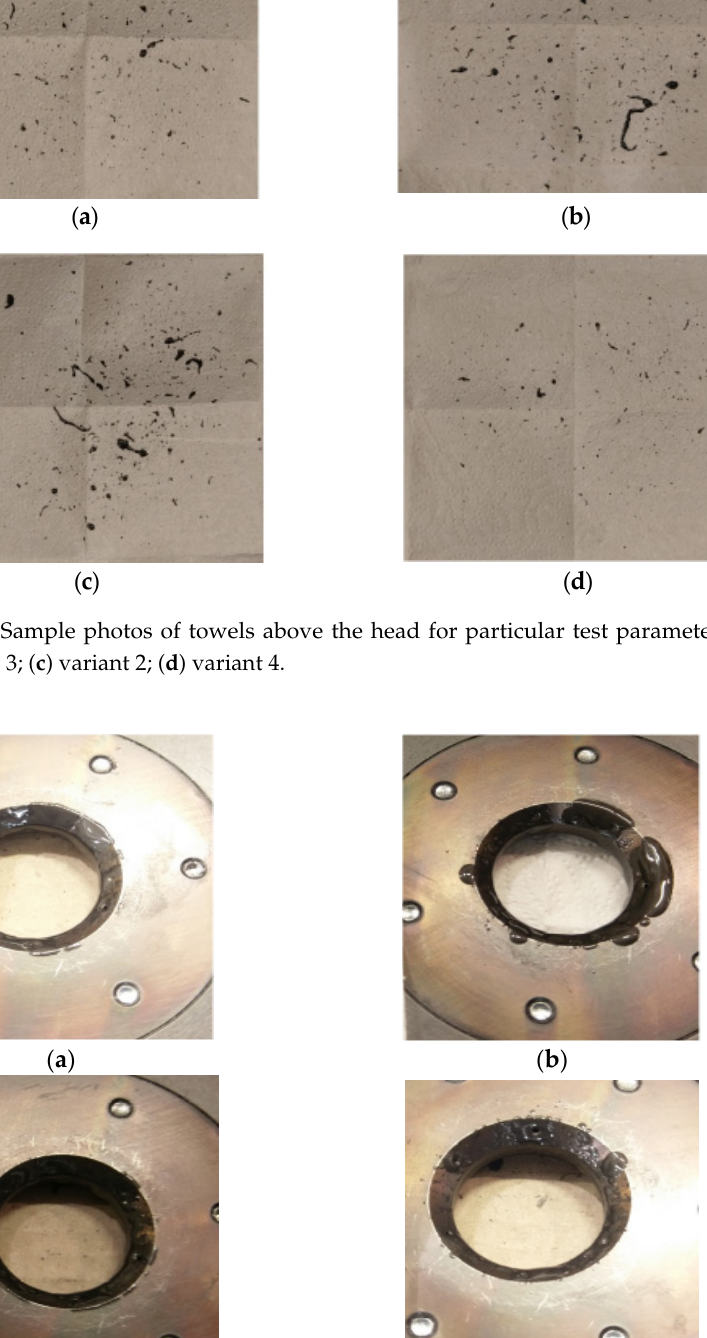
Figure 7. Lubricant remaining on the die for particular test parameters: ( a ) variant 1; ( b ) variant 3;